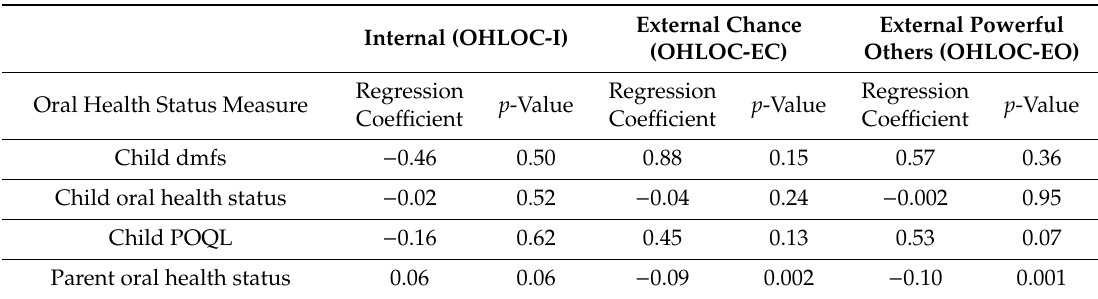
Table 6. Association between OHLOC subscale and oral health status of children and parents (N range =